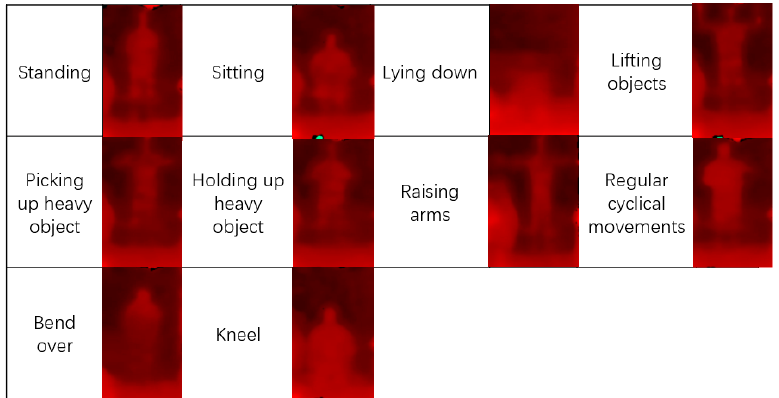
Figure 11. Example group of optimized depth motion capture for situation 2.